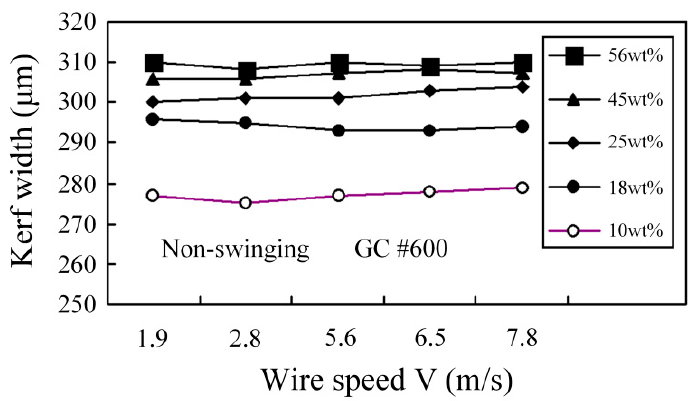
Figure 15. The energy-dispersive spectrometer (EDS) results for zone A.